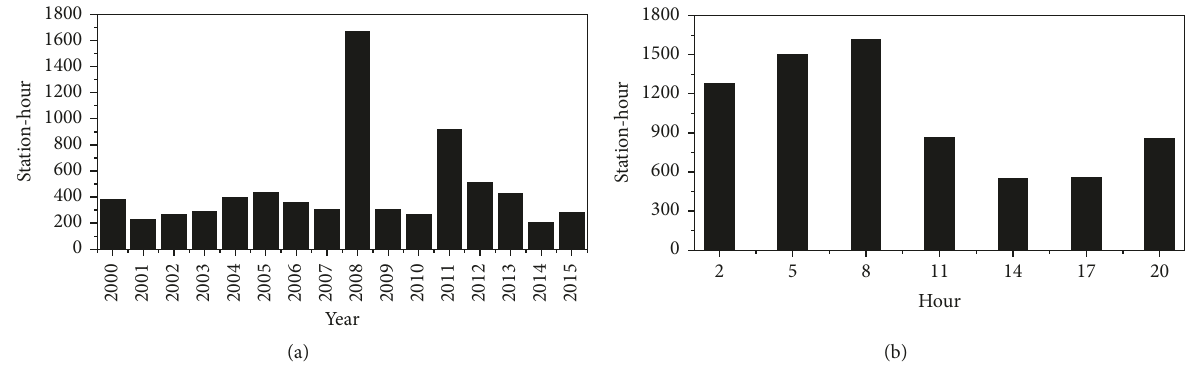
Figure 2: Temporal variation of freezing rain in China from 2000 to 2015. (a) Year and (b)